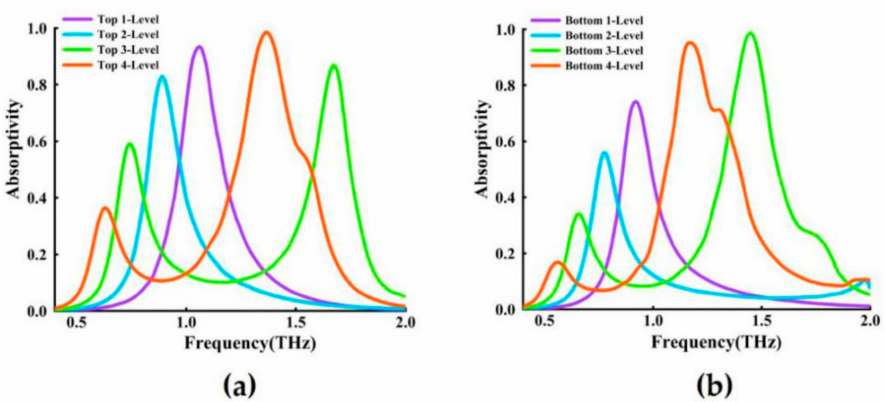
Figure 2. One-level to four-level cross fractal narrow-band absorption spectra: ( a ) top, ( b ) bottom. The bottom layer is composed of graphene fractal structures with the same